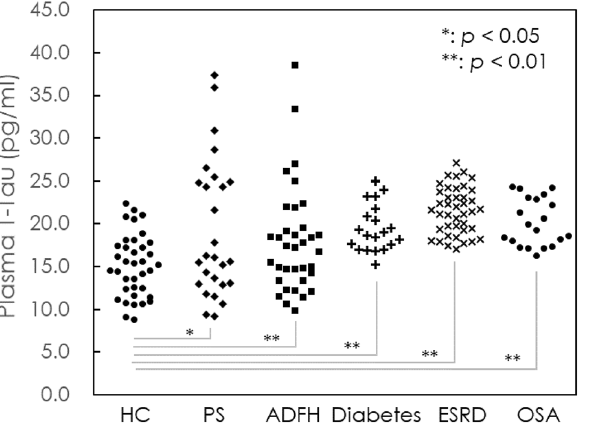
Figure 2. Dot plot of measured levels of T-Tau in the plasma of HCs, PS, ADFH, and ESRD, OSA and AD.